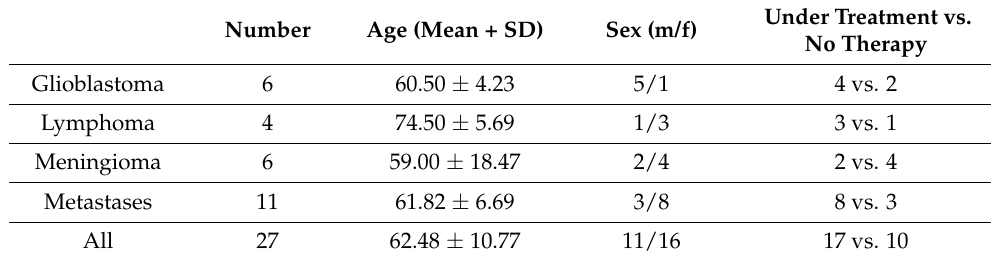
Table 1. Patients’